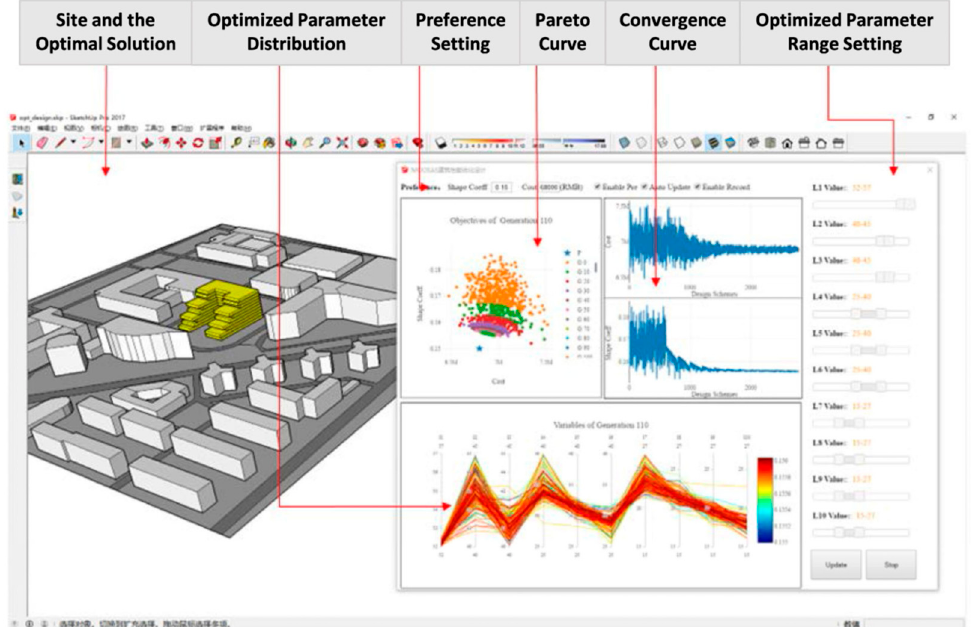
Figure 12. Building Performance Optimization (BPO) application developed on SketchUp.